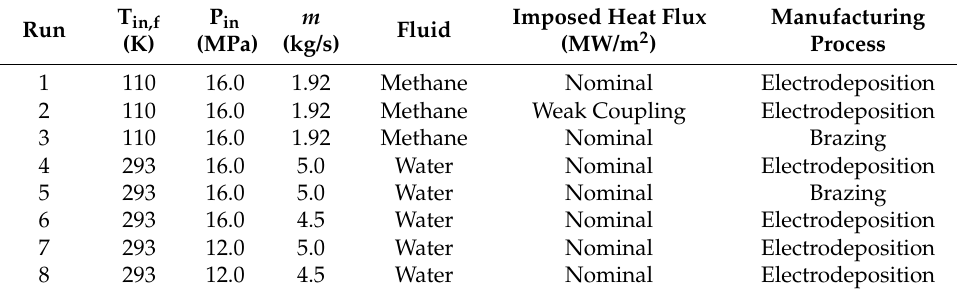
Table 3. Test matrix of present numerical